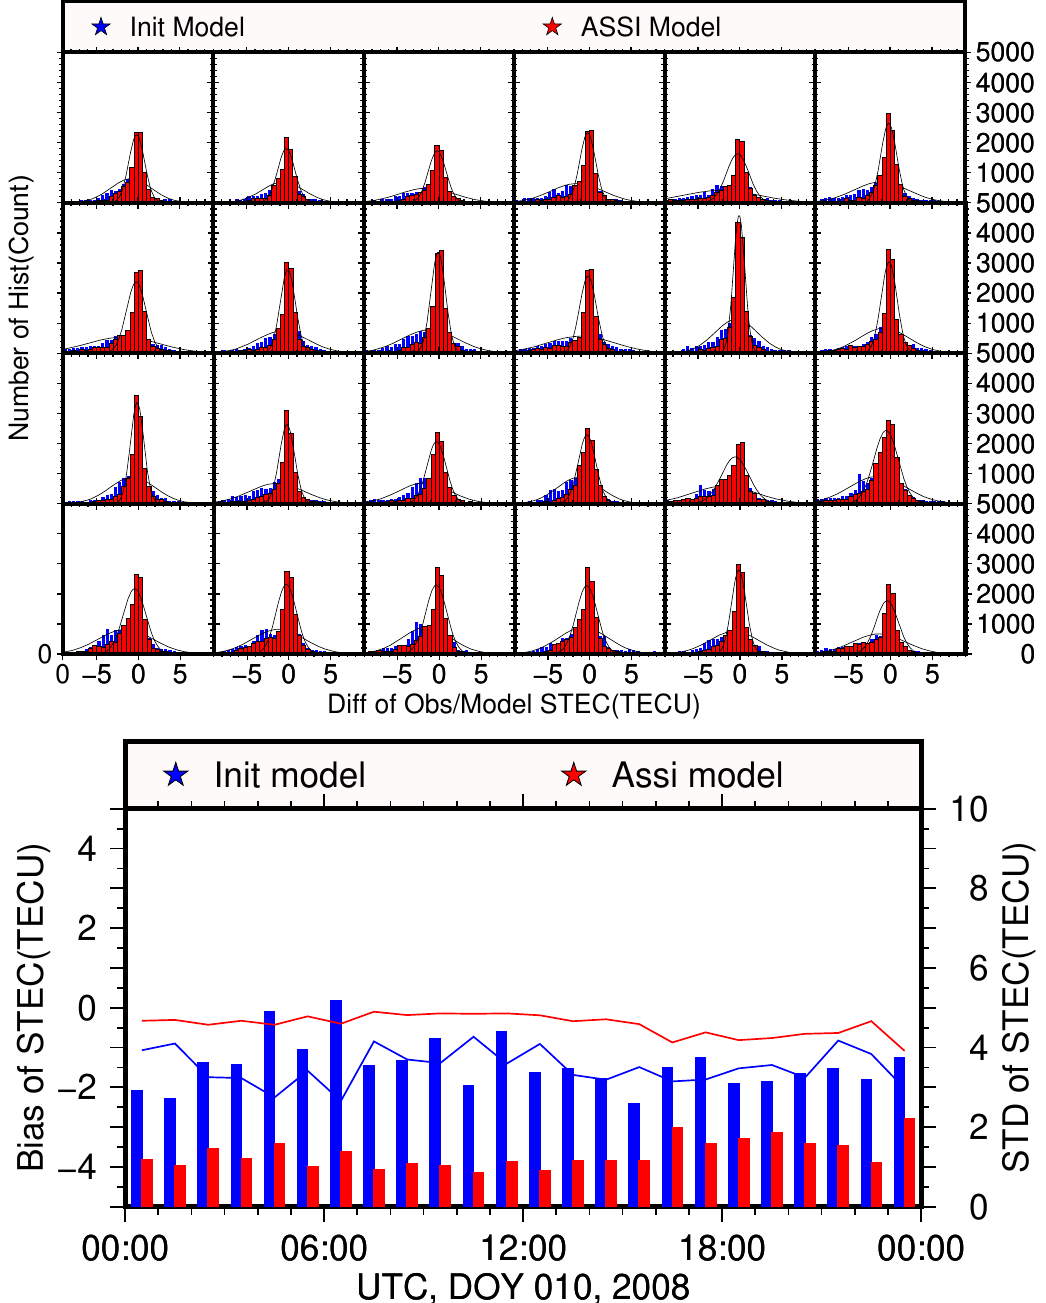
Figure 9. Residual statistics of the bottom model compared with observation data: ( top ) blue bars are the IRI model and red bars are the model assimilated using observation data with the IRI model; and ( bottom ) blue line and blue bar are the mean and RMS of the IRI model, respectively, while red line and red bar are the mean and RMS of the model assimilated using observation data with the IRI model. After assimilation with the ground-based/spaceborne ionospheric data, the assimilation model was corrected. The biases of the ionospheric model STEC and the observed STEC data were significantly reduced, revealing small deviations in the residuals and Gaussian distributions with small standard deviations. The bottom panel of Figure 9 shows the biases and standard deviations of the residuals of the observational data and the ionospheric model before and after the assimilation. This subfigure clearly illustrates that the STEC deviation was reduced from − 1.5 to 2.0 TECU before the